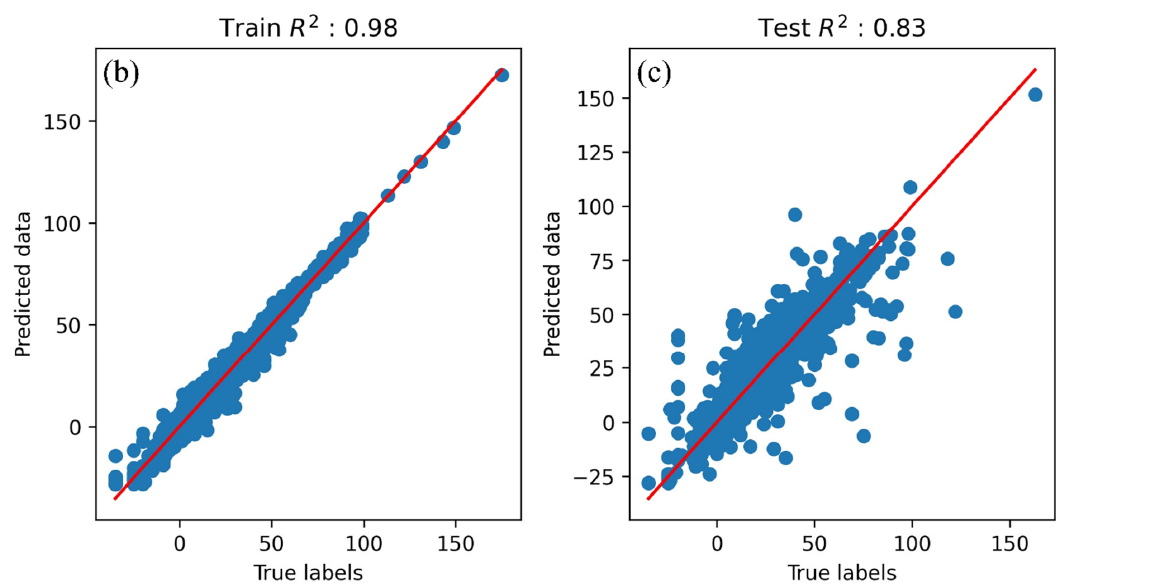
Figure 7. ( a ) Timeseries comparison between true labels (Katulampa water record levels, blue line) and LSTM RNN-predicted water level (orange line), with Sadewa’s rainfall value as an added information; scatterplot comparing predicted data vs. true labels for ( b ) training and ( c ) testing datasets.